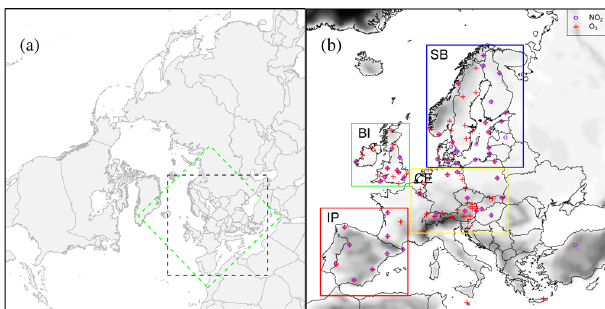
Fig. 1. Left panel: simulations with MM5 meteorology were run with a hemispheric domain (in the region shown), with a nested European domain (indicated by a black dashed box). Simulations with Eta meteorology used only a single nest (indicated by a green dashed box). Right panel: Locations of the NO 2 and O 3 EMEP monitoring stations are indicated within the Eta domain, and the terrain height used by DEHM is given by the density of the shad- ing. The coloured boxes outline the four sub-regions examined sep- arately within this